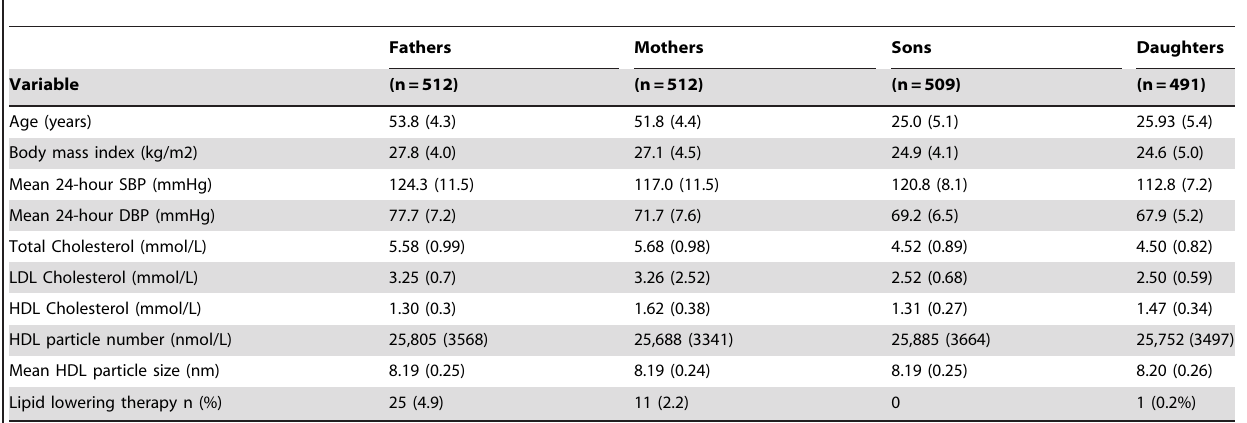
Table 1. Relevant characteristics of the GRAPHIC subjects partitioned by generation and